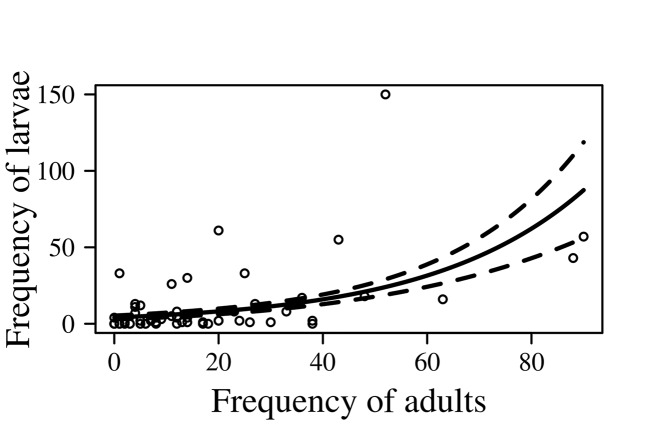
Relationship between the frequency of O. suberosus larvae and adults in L. olivacea nests on La Escobilla Beach, Oaxaca, Mexico.The solid line represents the values expected according to the ANCOVA. The dotted lines represent the standard error along the regression line.